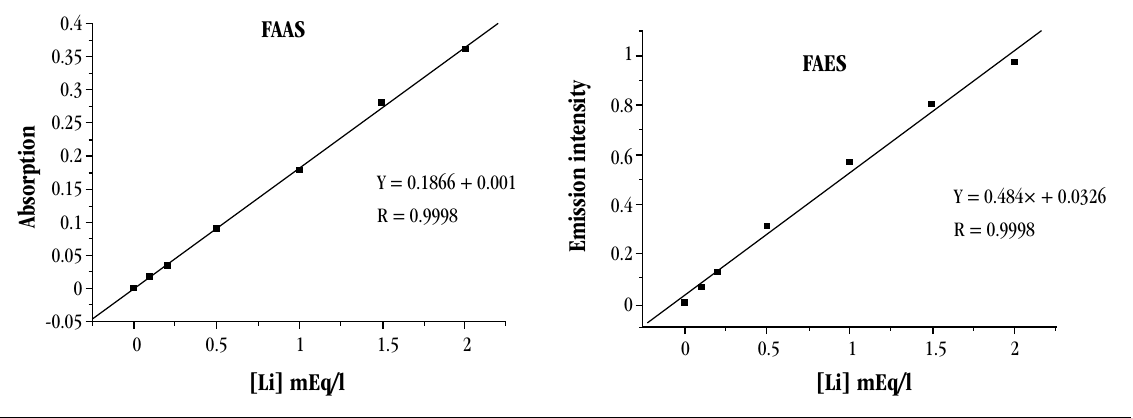
figurE 1 – Calibration curves for assessment of linearity by techniques FAAS and FAES FAAS: flame atomic absorption spectrometry; FAES: flame atomic emission